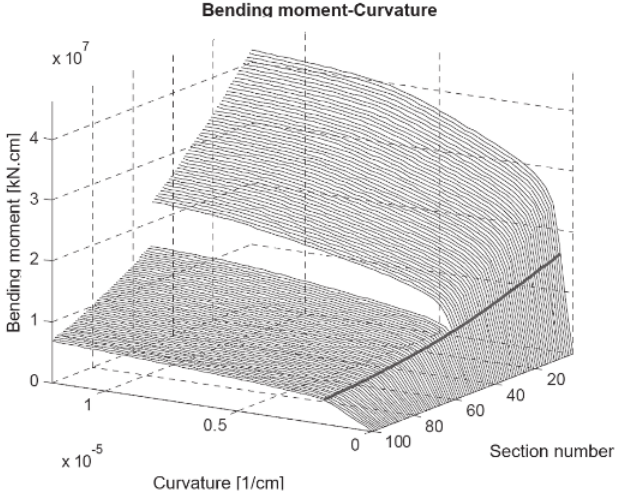
Figure 5 Bending moment-curvature diagrams associated with the internal forces in the ultimate combination (bending moment and axial load): sections along the tower for the complete prestressing level used along the 100 sections. The red line corresponds to the couple bending moment-curvature associated with internal forces in the ultimate combination